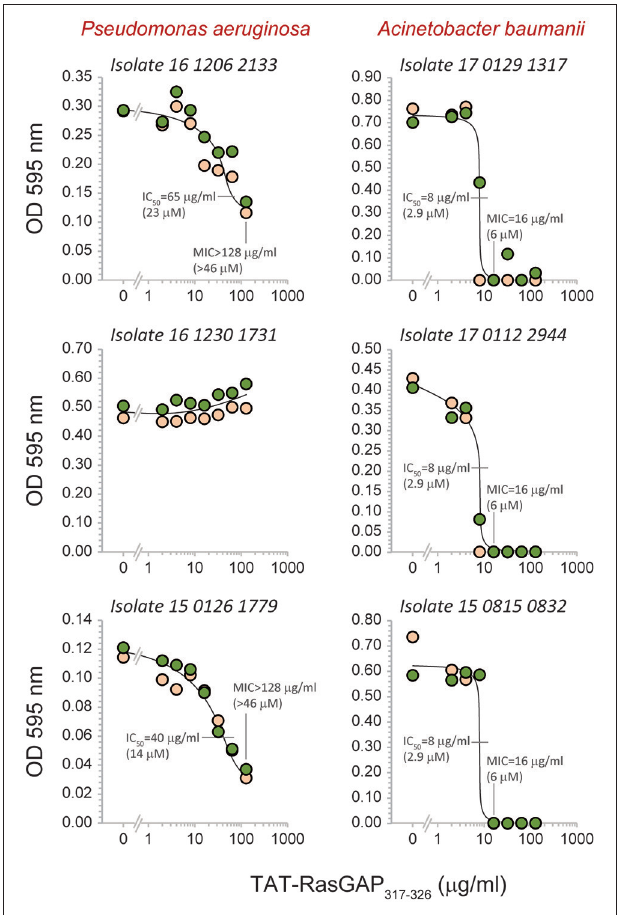
FIGURE 4 | Effect of TAT-RasGAP 317 − 326 on multi-drug resistant Acinetobacter baumannii and Pseudomonas aeruginosa . The indicated isolates were grown in the presence of the indicated concentrations of TAT-RasGAP 317 − 326 . The OD 595 nm was measured after 16h of incubation at 37 ◦ C. IC 50 , fifty percent maximal inhibitory concentration; MIC, Minimal inhibitory concentration. The results were derived from two different experiments (the data from each experiment labeled with a different color).